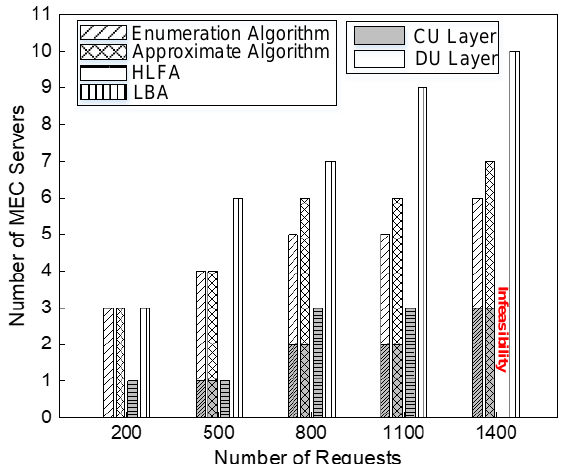
Figure 7. Comparisons of the number of MEC servers under different number of requests, when η 1 = 0.6.